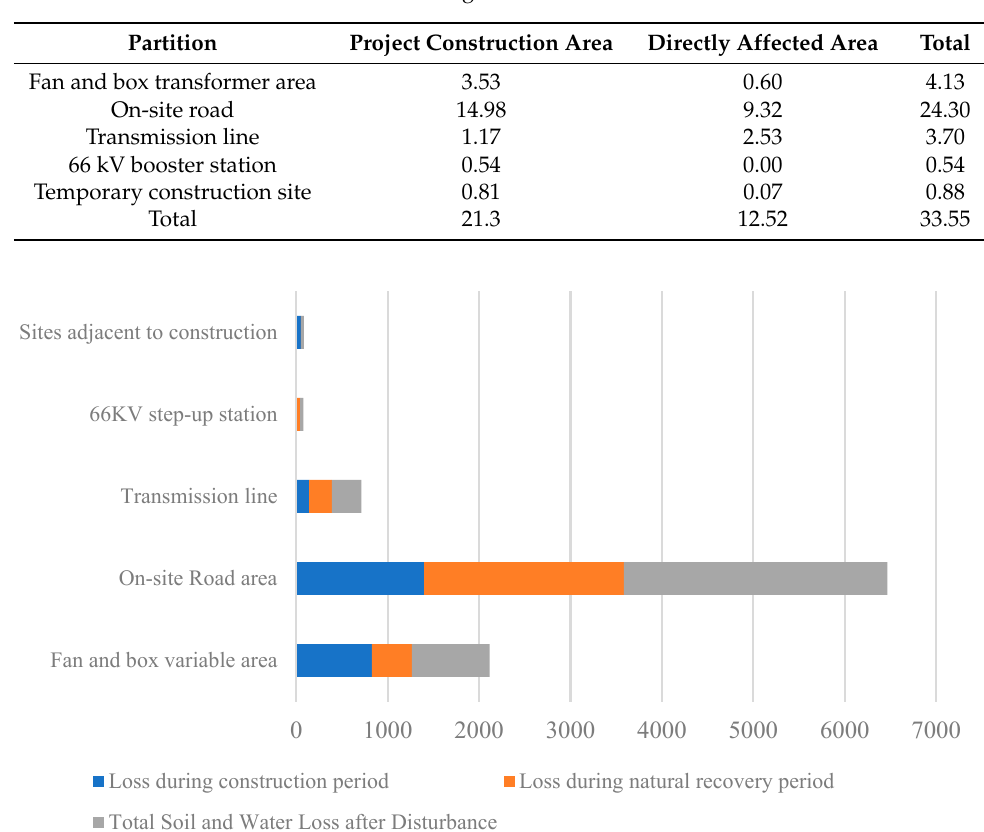
Table 6. Area of water and soil loss in each region.